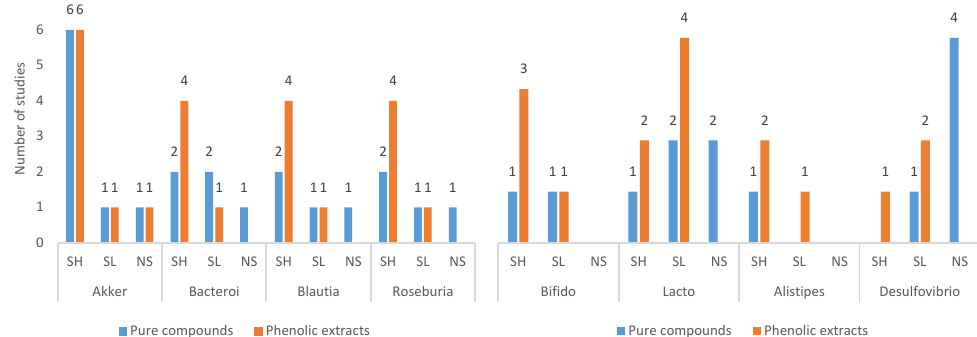
Figure 4. Frequently modulated gut microbes. Akker-Akkermansia, Bacteroi-Bacteroides, Bifi-do- Bifidobacterium, Lacto-Lactobacillus, SL-Significantly Low, SH-Significantly High. NS-Not Sig- nificant. Significance/non-significance compared to HFD .